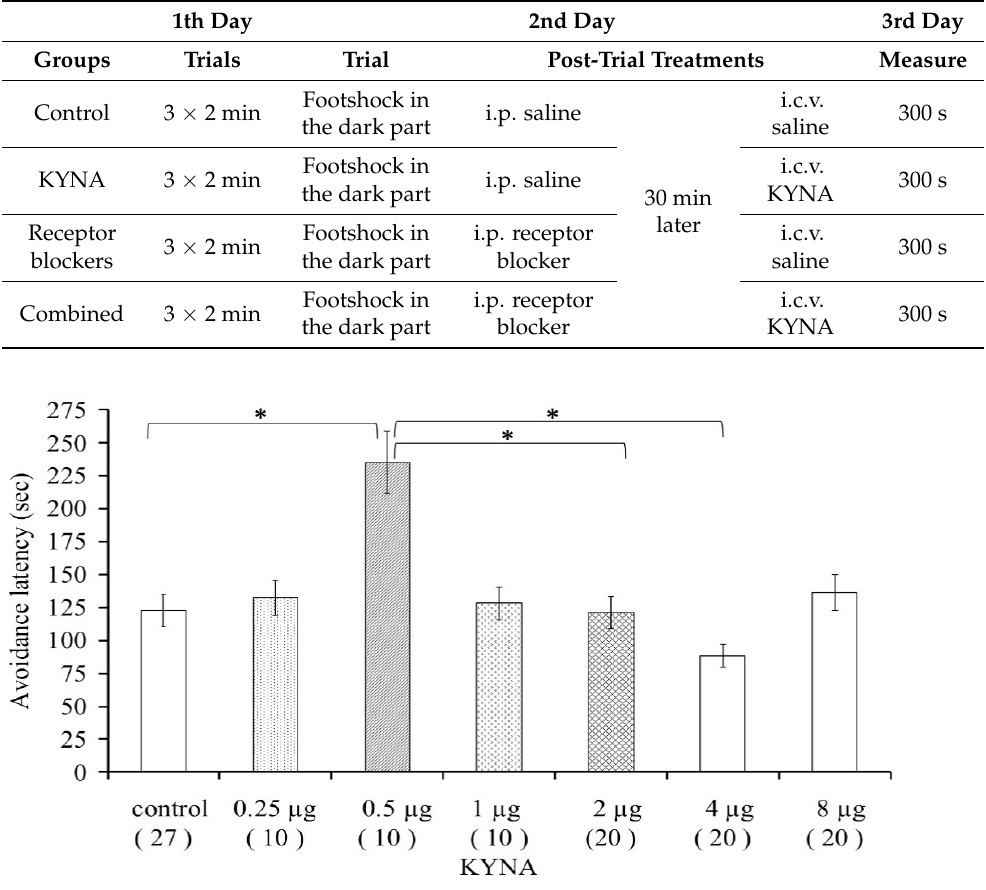
Figure 2. Dose–response examination of kynurenic acid in mice concerning the passive avoidance latency. * p < 0.05, the data in the plots are presented as means ± SEM. The exact subject numbers per group are indicated in brackets below the corresponding bar in the plots.